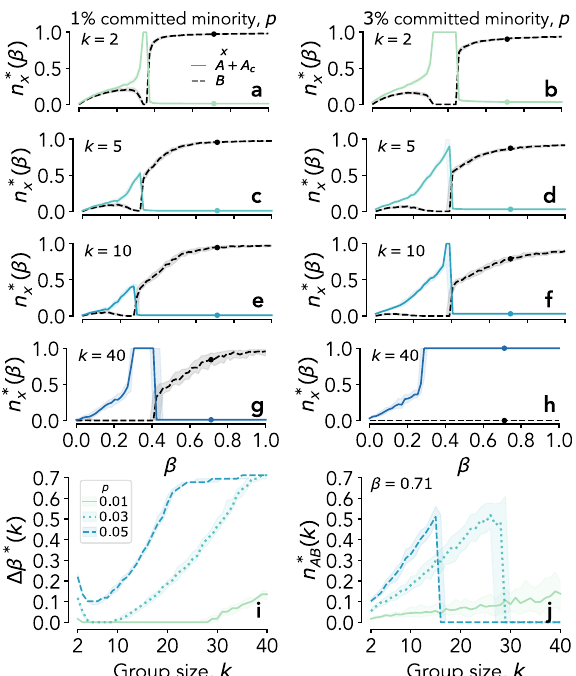
Fig. 4 Higher-order (group) effects in the naming game (NG) for different values of the social in fl uence parameter β . We consider ( k − 1) − uniform hypergraphs, i.e. regular structures in which each interaction involves exactly k agents. Group agreement follows the unanimity rule. a – h The density of nodes supporting name x in the stationary state, n (cid:1) x ð β Þ , obtained by means of numerical simulations, is shown as a function of the social in fl uence parameter β ( A c : committed minority). Lines (continuous and dashed, respectively associated to names A + A c and B ) and shaded areas refer to the median values and values contained within the 25th and 75th percentiles of the 50 numerical simulations. a , c , e , g and b , d , f , h correspond to simulations with different sizes of committed minorities supporting name A , namely fractions p = 0.01 and p = 0.03 of the population. In the initial state, all the other agents hold norm B . Four different group sizes are considered: k = 2 ( a , b ), k = 5 ( c , d ), k = 10 ( e , f ) and k = 40 ( g , h ). The range Δ β * of β values for which n (cid:1) A ¼ 1 (i.e., the committed minority manages to convert the whole population), is plotted in ( i ) as a function of the group size k and for different values of the fraction p of committed (see legend). We show in Supplementary Figure 8 the equivalent of this panel for the union rule. j Fraction of nodes n (cid:1) AB holding both names in the stationary state as a function of k for different values of p